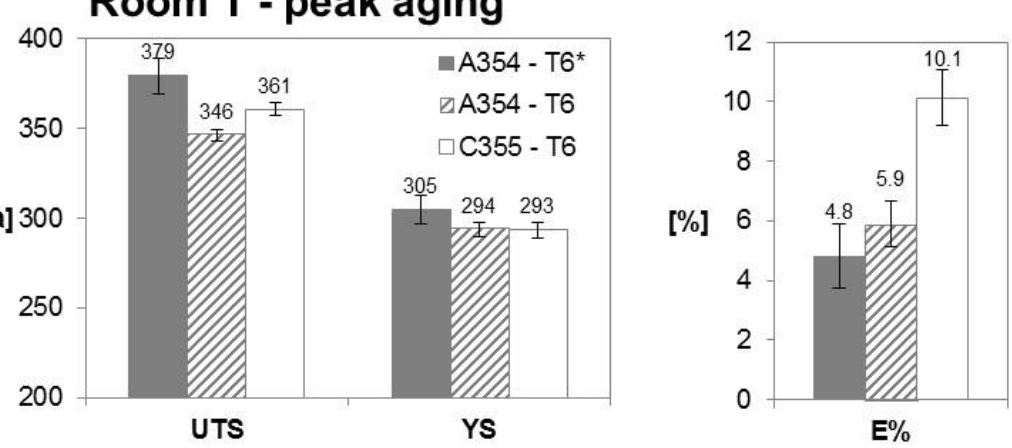
Figure 11 . Tensile properties of A354-T6*, A354-T6, and C355-T6 alloys at room temperature in the artificial aging condition, readapted from Reference [21].